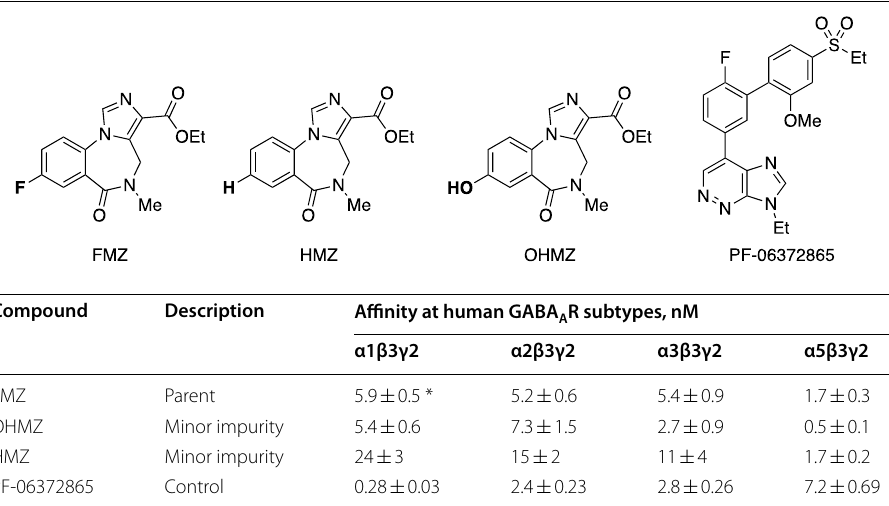
SEM of n 4 separate assays ± =